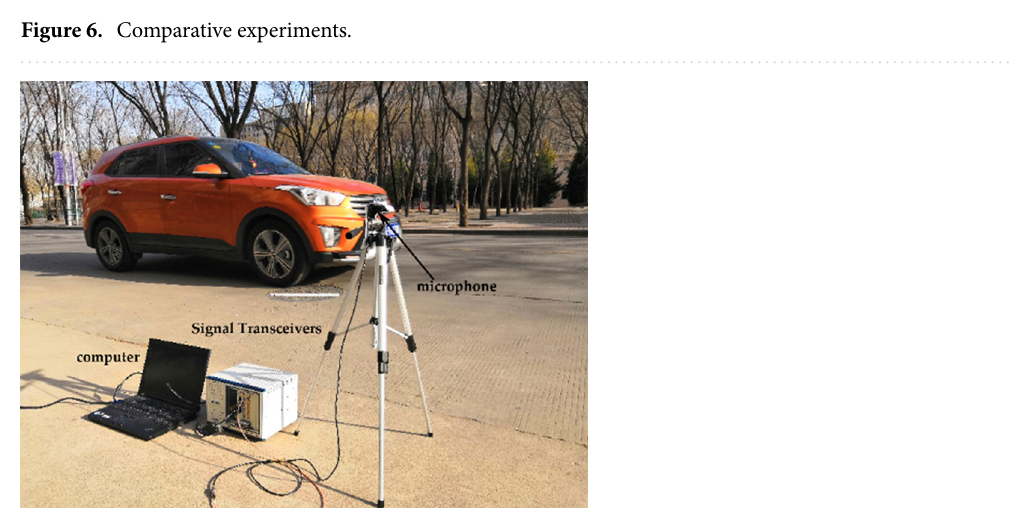
Figure 7. The process of audio